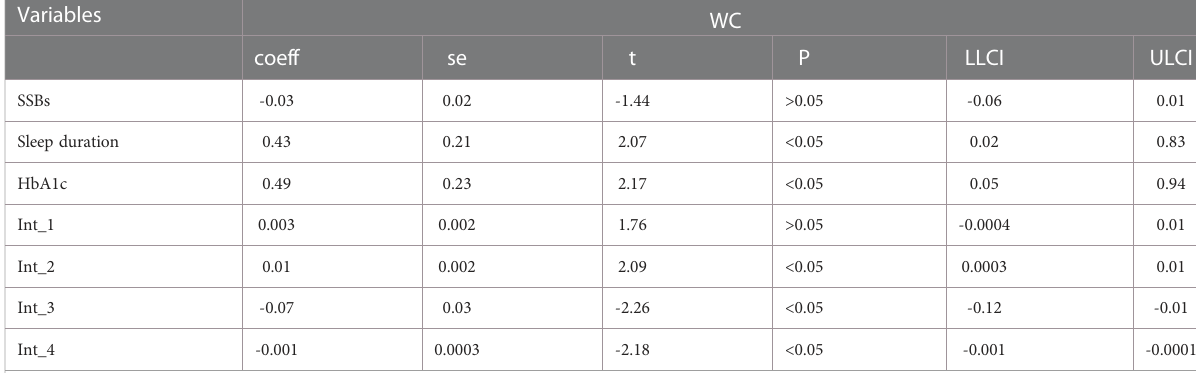
TABLE 8 The moderation analysis between SSBs, Sleep duration, HbA1c and WC.